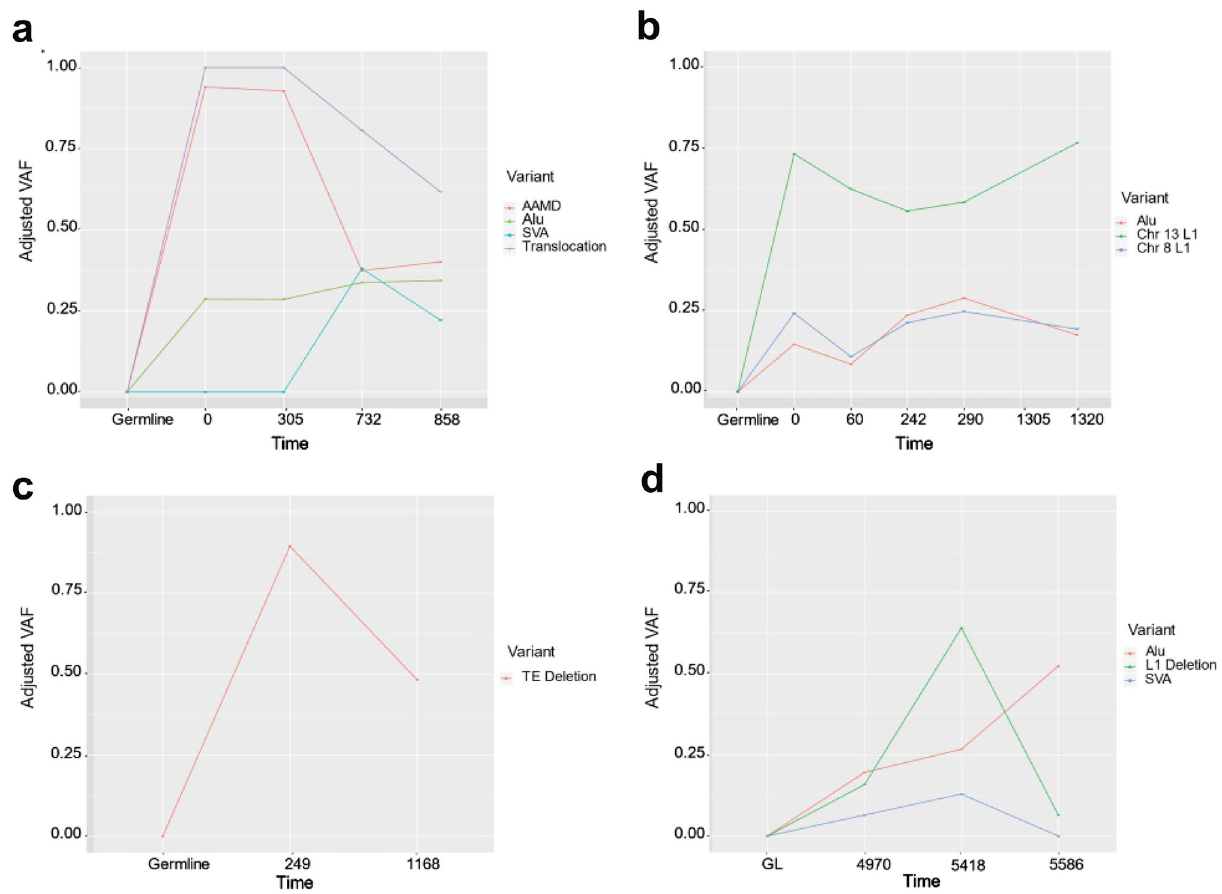
Figure 2. Adjusted VAF for each of the 4 patients. Parts ( A – D ) correspond to patients 1–4, respectively. The VAF for each patient has been adjusted to better reflect the percentage of cells in the sample that appear to be from the tumor. VAF is shown on the Y axis with each sampling timepoint for a particular patient shown on the X axis.